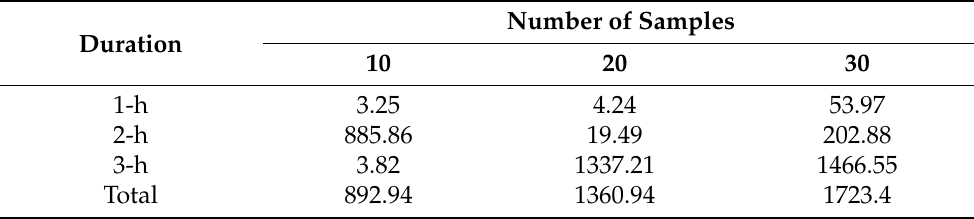
Table 3. Optimal building capacity for BESSs with different numbers of samples (MW).